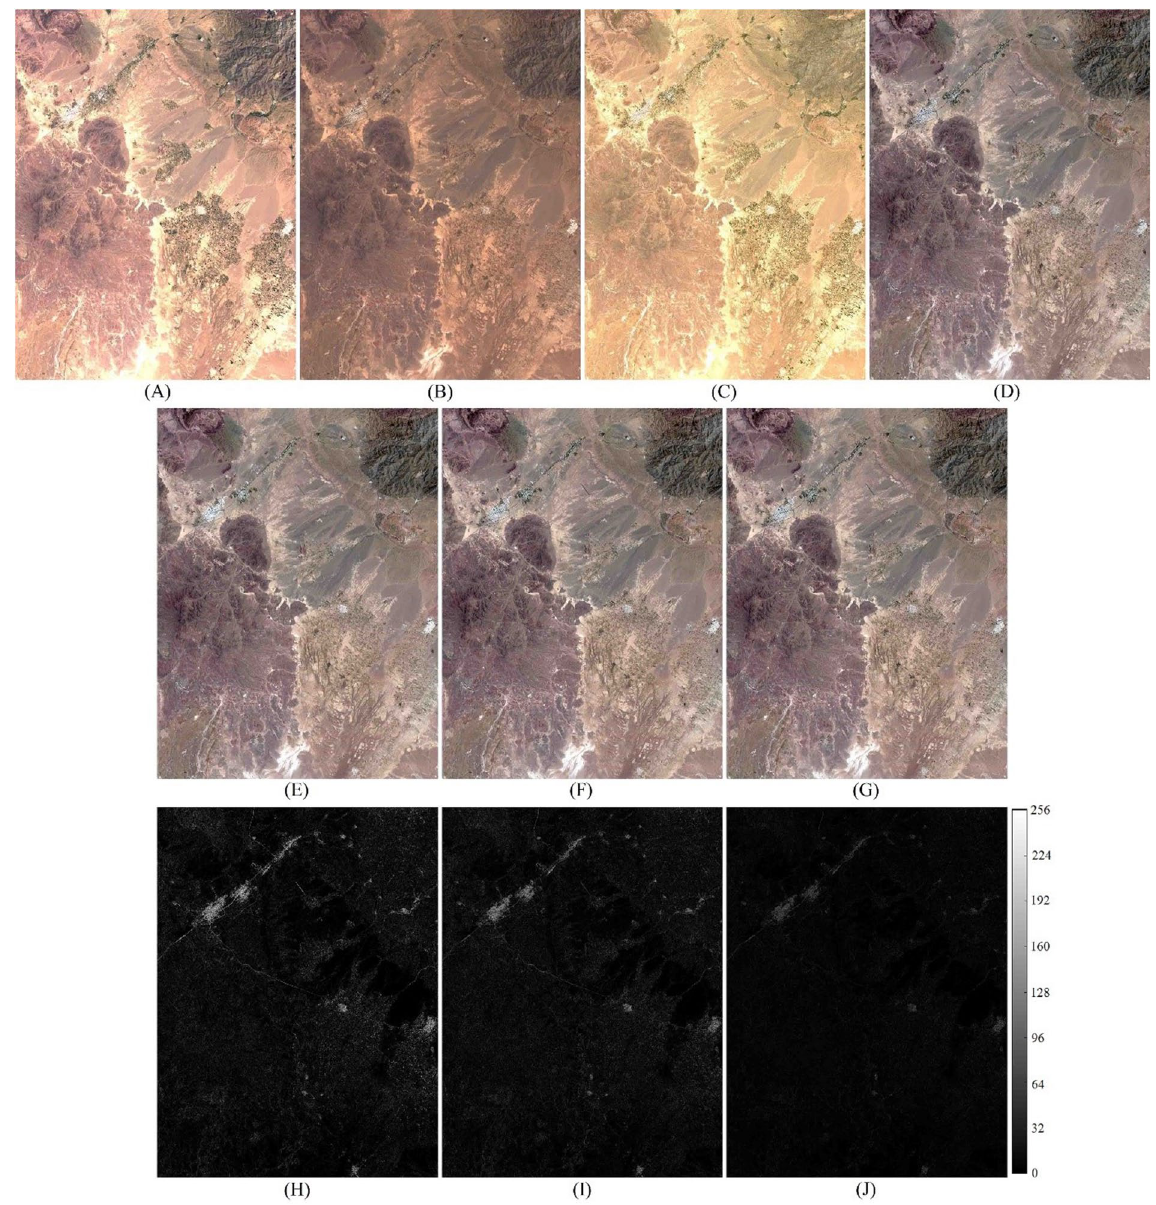
Figure 4. True color input images acquired from Khorasan-e Razavi Province; ( A , B ) upsampled OLI 1 and OLI 2 , ( C , D ) corresponding MSI 1 and MSI 2 , ( E , F , G ) predicted MSI 2 using Fit-FC, FSDAF, and STSR approach, and ( H , I , J ) intensity difference map between predicted MSI 2 and real MSI 2 . Scale bar shows the difference between predicted and real MSI 2 on a 12-bit